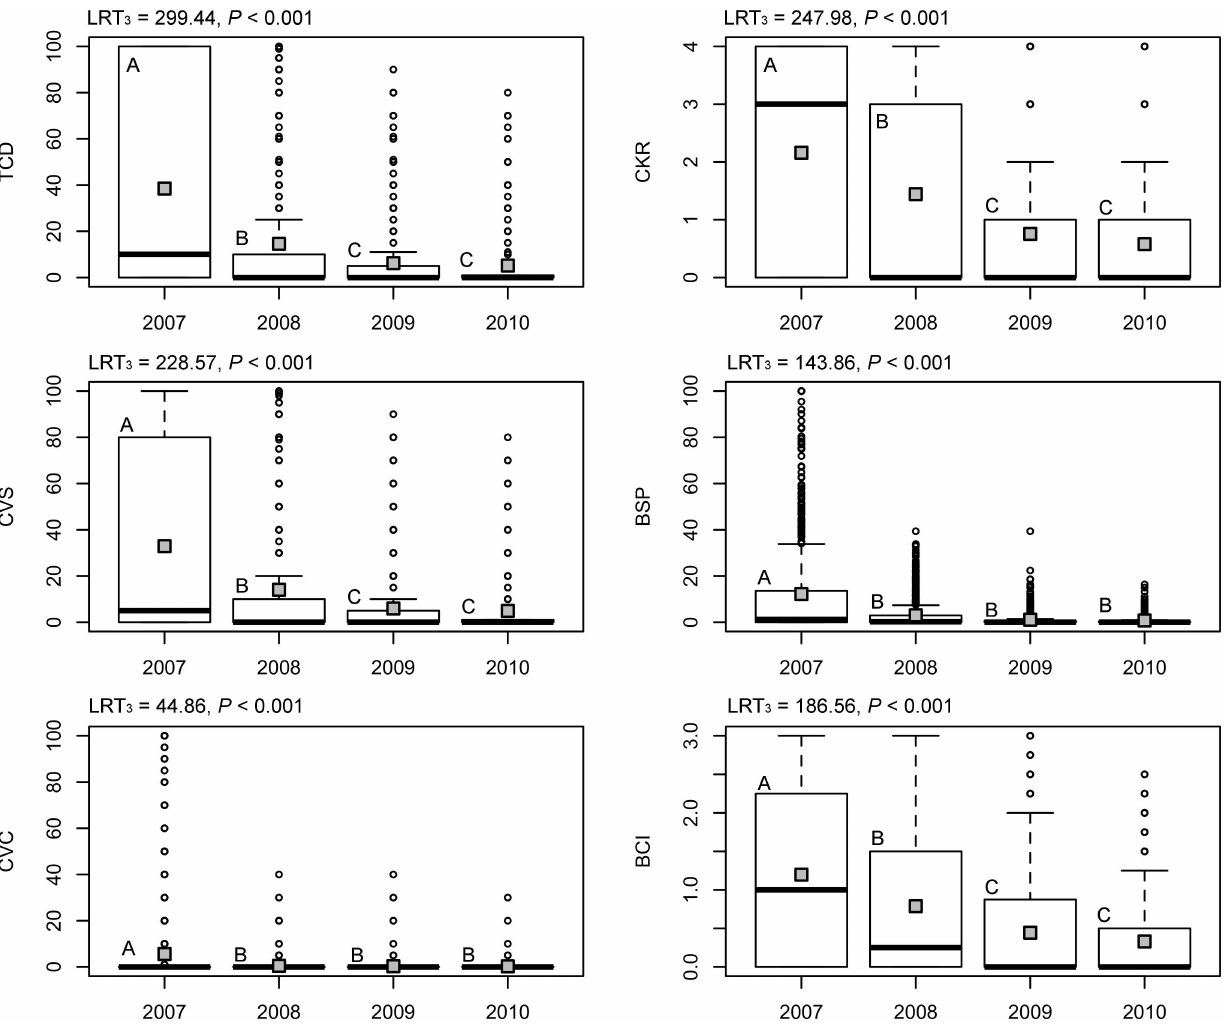
Fig 2. Changes in fire injury distributions among living lodgepole pines over time since fire. Dark lines within boxplots indicate the median and grey boxes indicate mean for six fire injury measurements. Different letters denote significant differences ( α (cid:20) 0.05) between years from generalized linear mixed models with Tukey HSD pairwise comparisons. All trees were considered live in